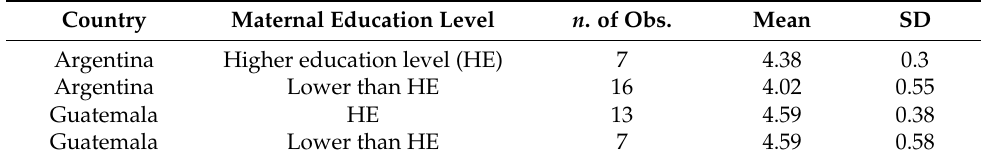
Table 7. Country and maternal education level.